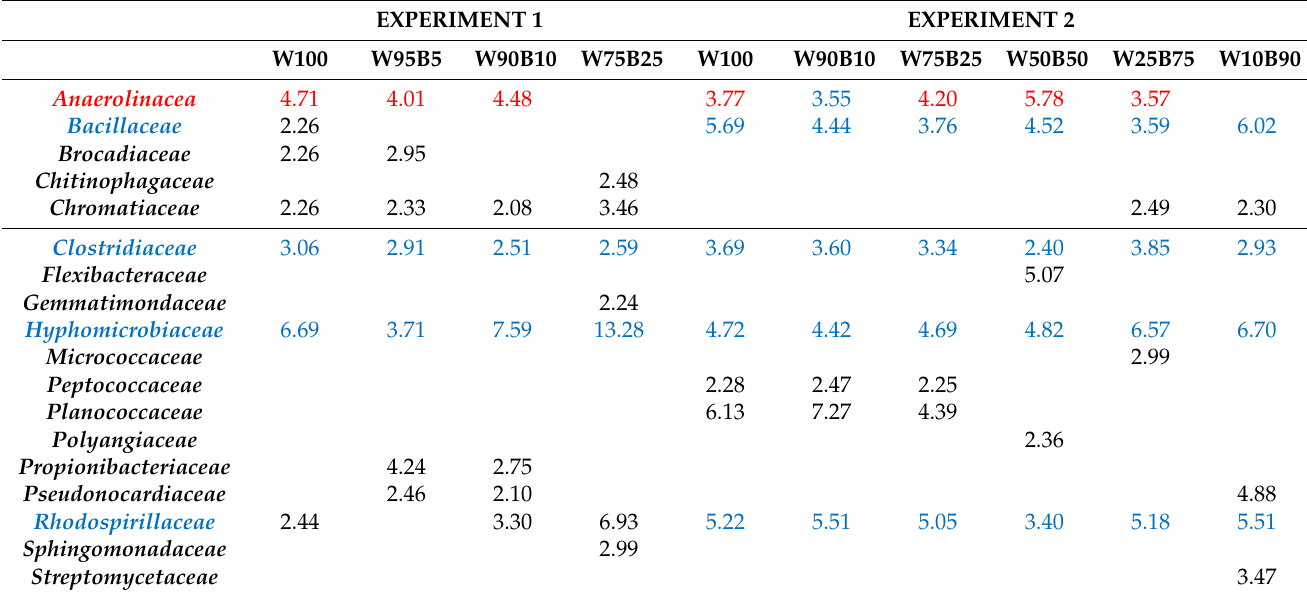
Legend: Blue text indicates microbes found in all experimental samples; red text indicates microbes found in all samples below the specified concentration of biochar; black text indicates microbes found inconsistently among